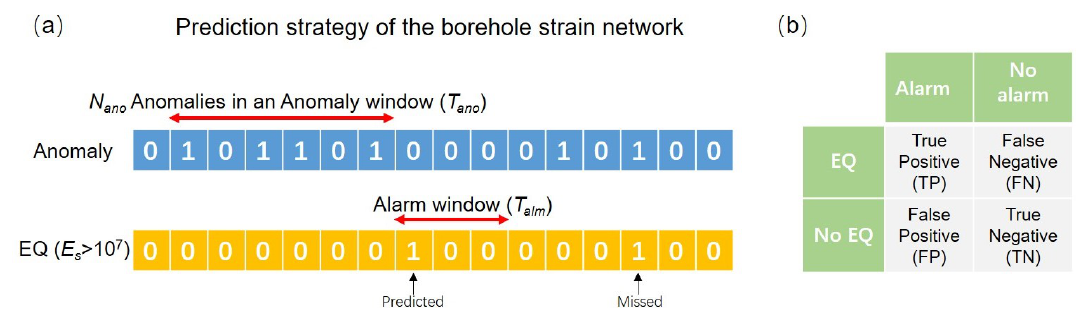
Figure 4. ( a ) Schematic diagram of the prediction strategy of the borehole strain network. We assume that a target earthquake with E s ≥ 10 7 will occur in an alarm window, T alm , if N ano ≥ T ano /2. ( b ) Confusion matrix of the prediction